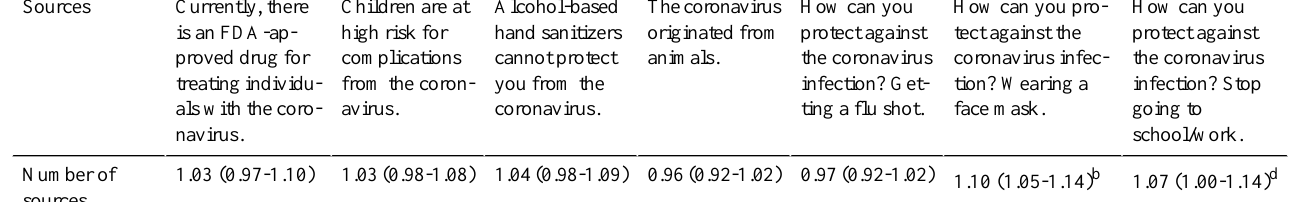
How can you can you pro- mask.How can you shot.The coronavirus animals.Alcohol-based coronavirus.Children are at protect against tect against the protect against originated from hand sanitizers high risk for the coronavirus coronavirus infec- the coronavirus cannot protect complications tion? Wearing a infection? Get- you from the from the coron- going to face ting a flu